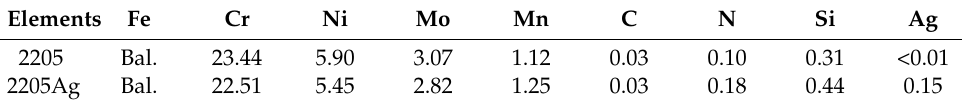
Table 1. Chemical composition of the 2205 and 2205Ag used in this study (mass%).